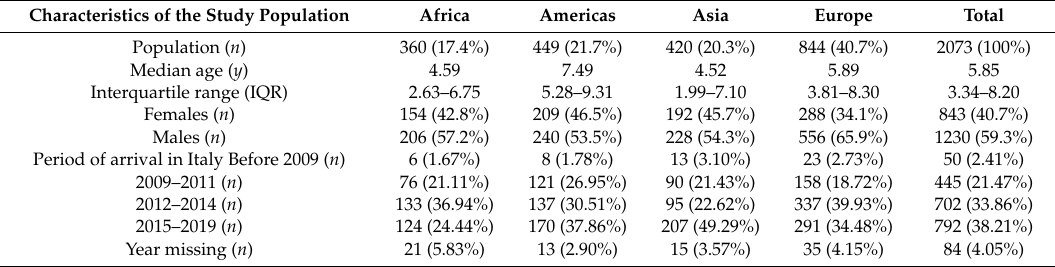
Table 1. Characteristics of the study population by continent of origin median age, gender, and period of arrival in